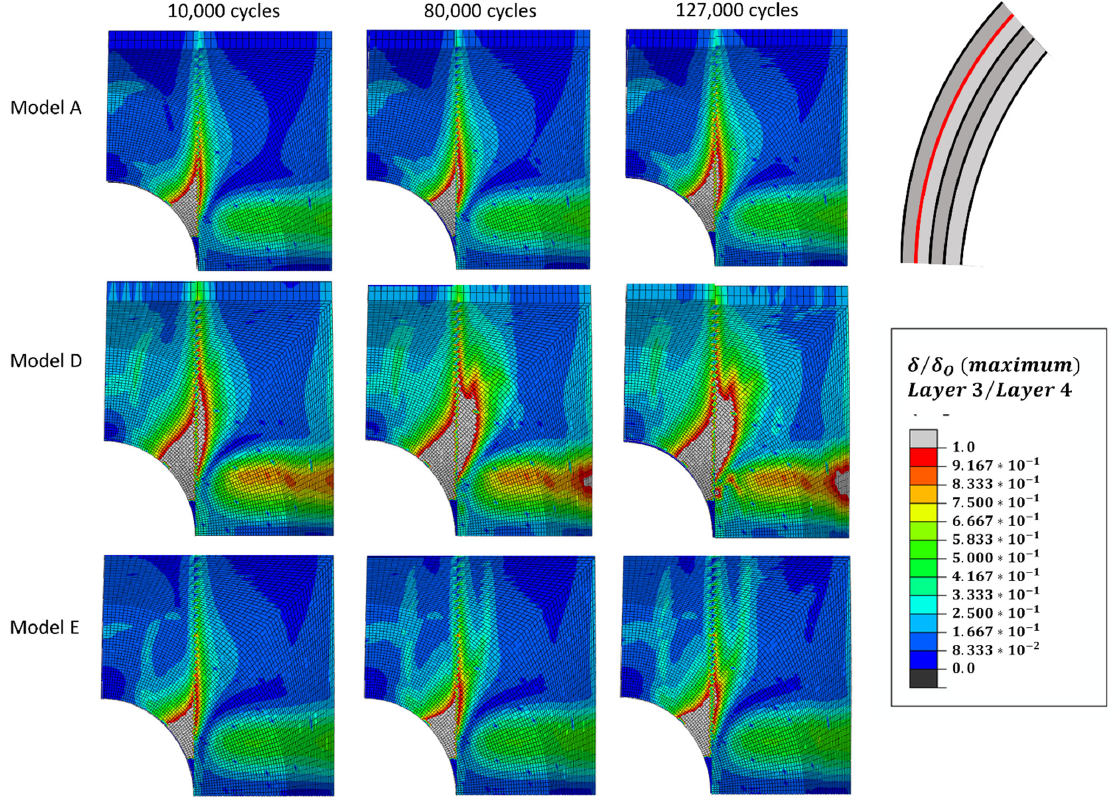
Figure 30. FEA delamination between the most delaminated layers in the model, layer 3 and 4, as indicated in the